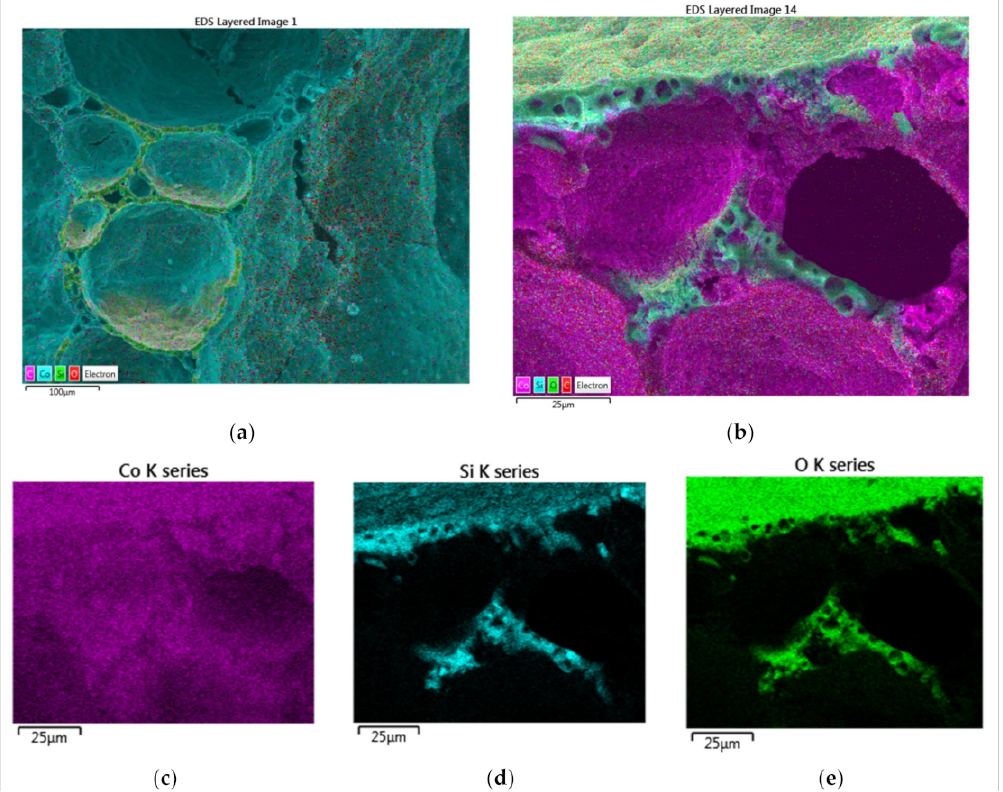
Figure 21. EDS images and elemental mapping of the Co / Si = 2 catalyst. ( a ) at low magnification with [Co] = 0.669; [Si] = 0.043; [O] = 0.288 (scale bar = 100 µ m); ( b ) at high magnification with [Co] =